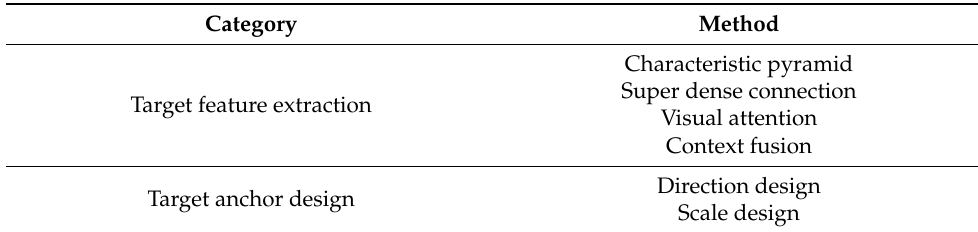
Table 2. Summary of CNN-based SAR ship detection